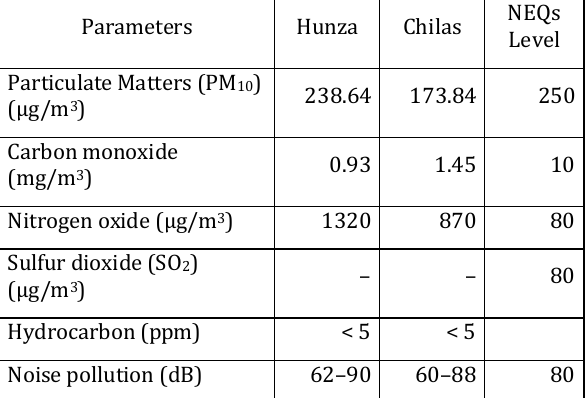
Table 8. Concentrations of air pollutants in major city/towns of study area (GB-EPA, 2012a)